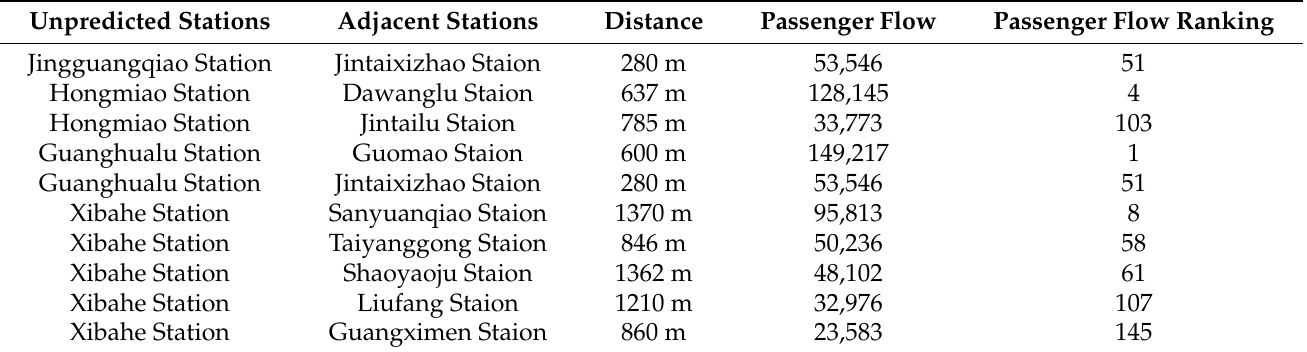
Table 2. Relationship between unpredicted stations and its adjacent